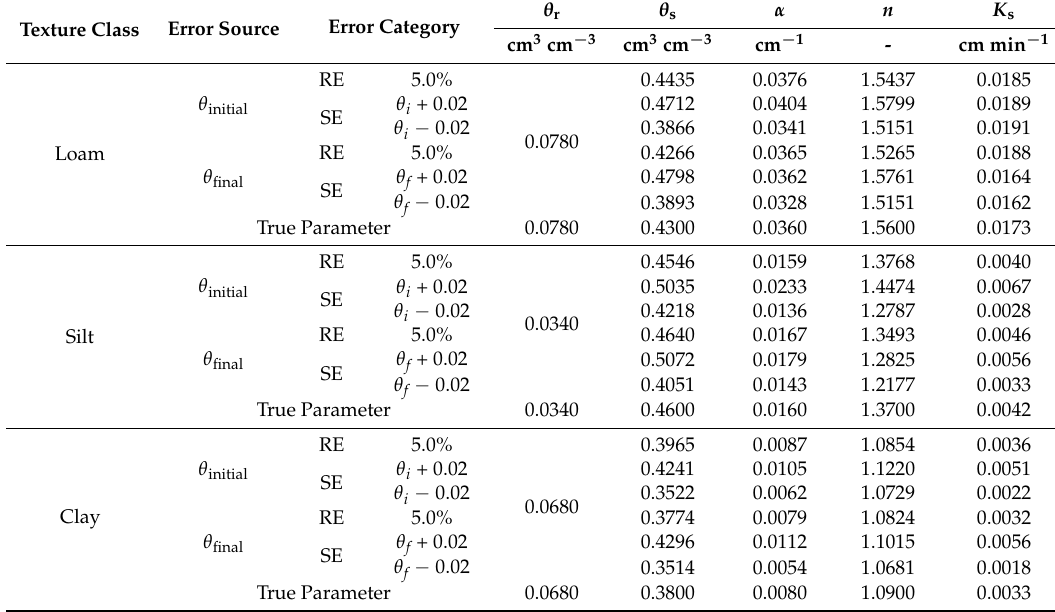
Figure 8. Comparison of SWRCs ( a1 , b1 , c1 , d1 ) and conductivity curves ( a2 , b2 , c2 , d2 ) with random errors (RE) and system errors (SE) for various treatments with objective function ψ ( θ initial ): ( a ) Sand; ( b ) Loam; ( c ) Silt; and ( d ) Clay.